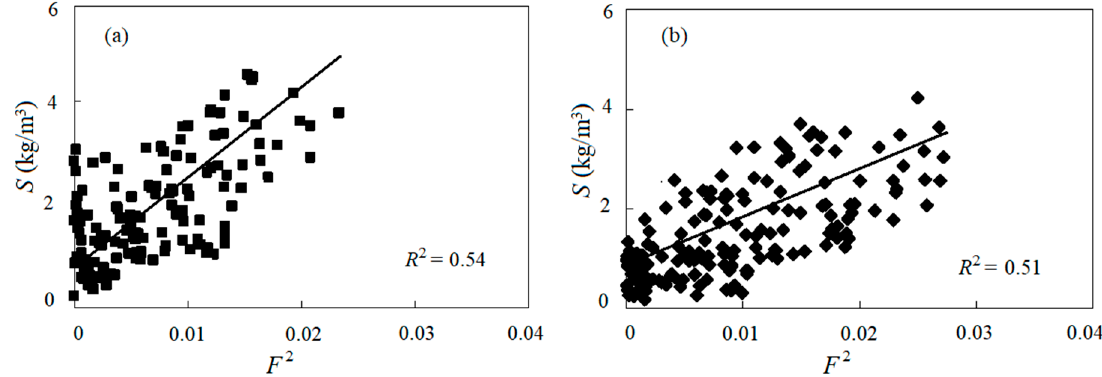
Figure 13. S – F 2 relationship for the wet season (June 2015): ( a ) Flood tides; ( b ) Ebb tides. The S c expression for the meander reach is written as